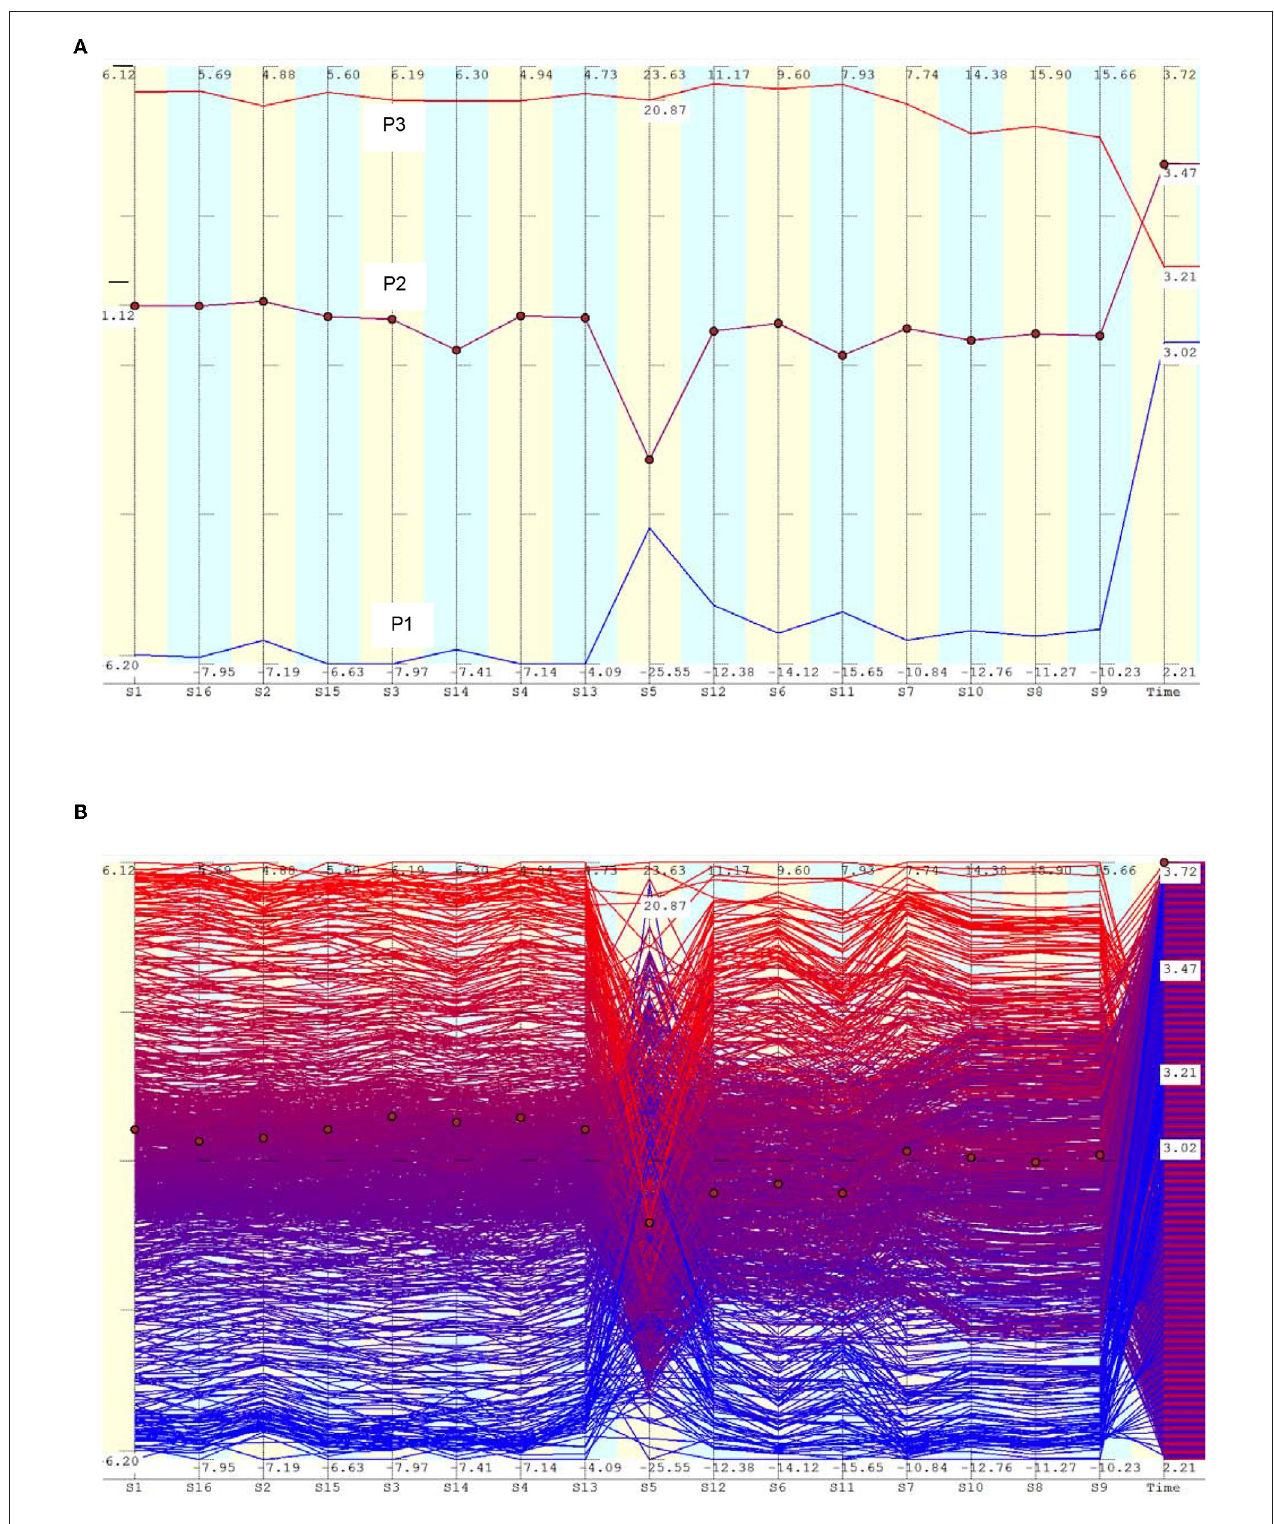
FIGURE 3 | Parallel axis plot of strain data during the free vibration phase. (A) Plot of three data points to show the trend. These data belong to the free vibration period, when the train is far away from the span, roughly 986m from the edge of the girder. The train was moving at a speed of 17.3 m/s. (B) Data points within a selected time